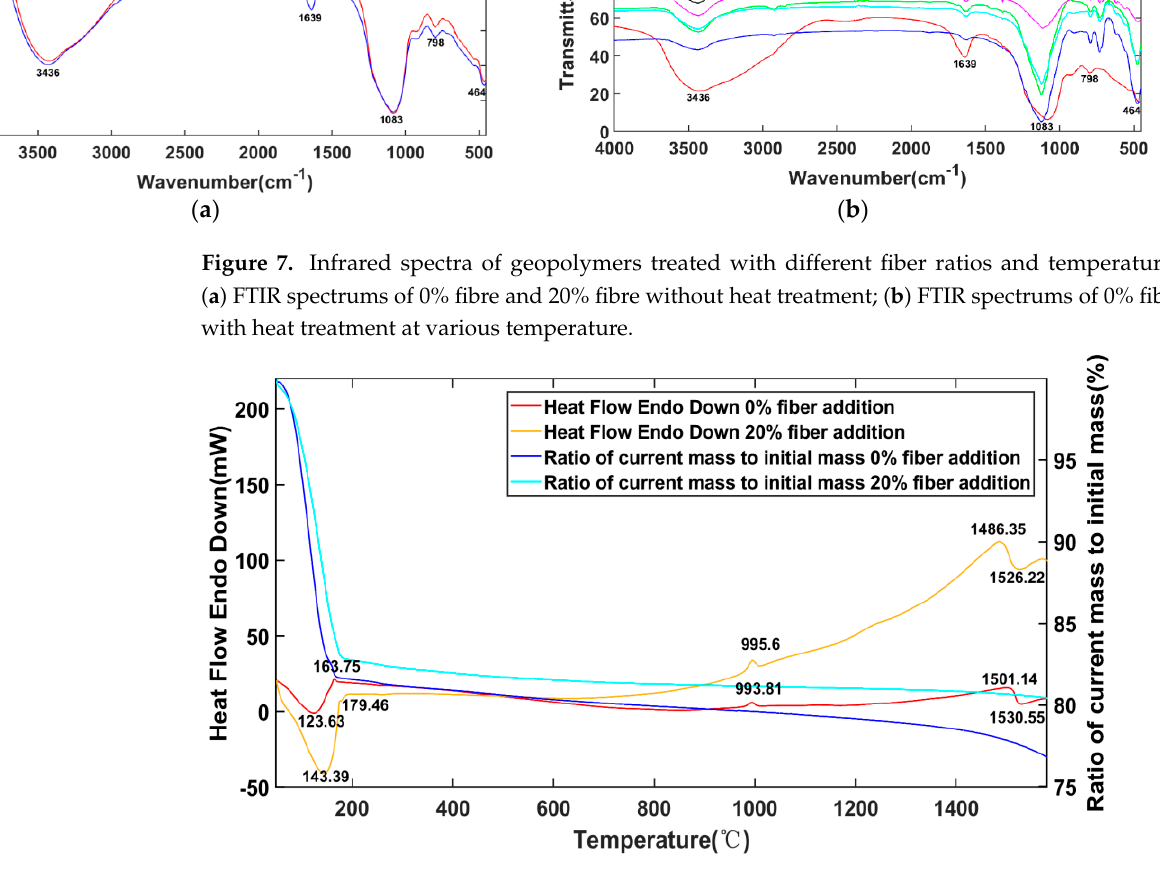
Figure 8. Results of differential thermal analysis of samples.